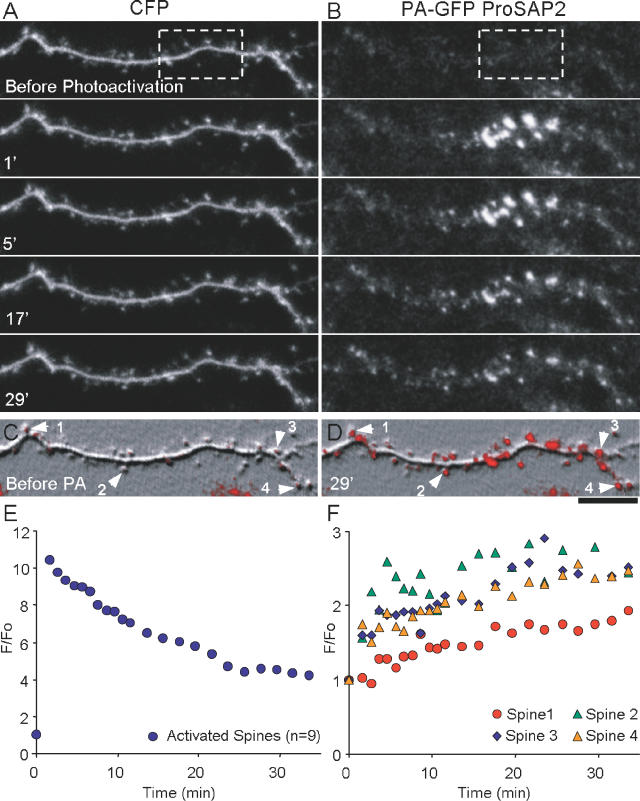
ProSAP2 Lost from Dendritic Spine Heads Is Incorporated into PSDs of Adjacent SpinesA dendritic segment expressing both CFP (A) and PA-GFP:ProSAP2 (B). At time t = 0, PA-GFP:ProSAP2 within the region enclosed in rectangles was photoactivated by selective illumination at 405 nm. With time from photoactivation, fluorescence at tips of remote spines increased, whereas spine head fluorescence within the photoactivated region diminished. The contrast in (B) was enhanced linearly to emphasize fluorescence changes in remote spines, resulting in the apparent saturation at photoactivated spines. Spatial relationships between spines and PA-GFP:ProSAP2 puncta before and 29 min after photoactivation are shown in (C) and (D), respectively. In these images, PA-GFP:ProSAP2 fluorescence data were overlaid onto the CFP images after rendering the latter with the “emboss” filter of Adobe Photoshop. Note that PA-GFP:ProSAP2 fluorescence is restricted to spine heads, with little fluorescence observed in spine necks or the dendrite shaft. This distribution indicates that the PA-GFP:ProSAP2 that migrated to adjacent spines had become integrated into the PSD at these sites. Bar, 10 μm. Quantification of fluorescence changes at photoactivated (E) and neighboring spine heads (F) reveals a gradual decrease of fluorescence in the photoactivation region concomitant with fluorescence increases at nearby spines, most prominent at spines nearest to the photoactivation site. Values are normalized to prephotoactivation fluorescence levels.